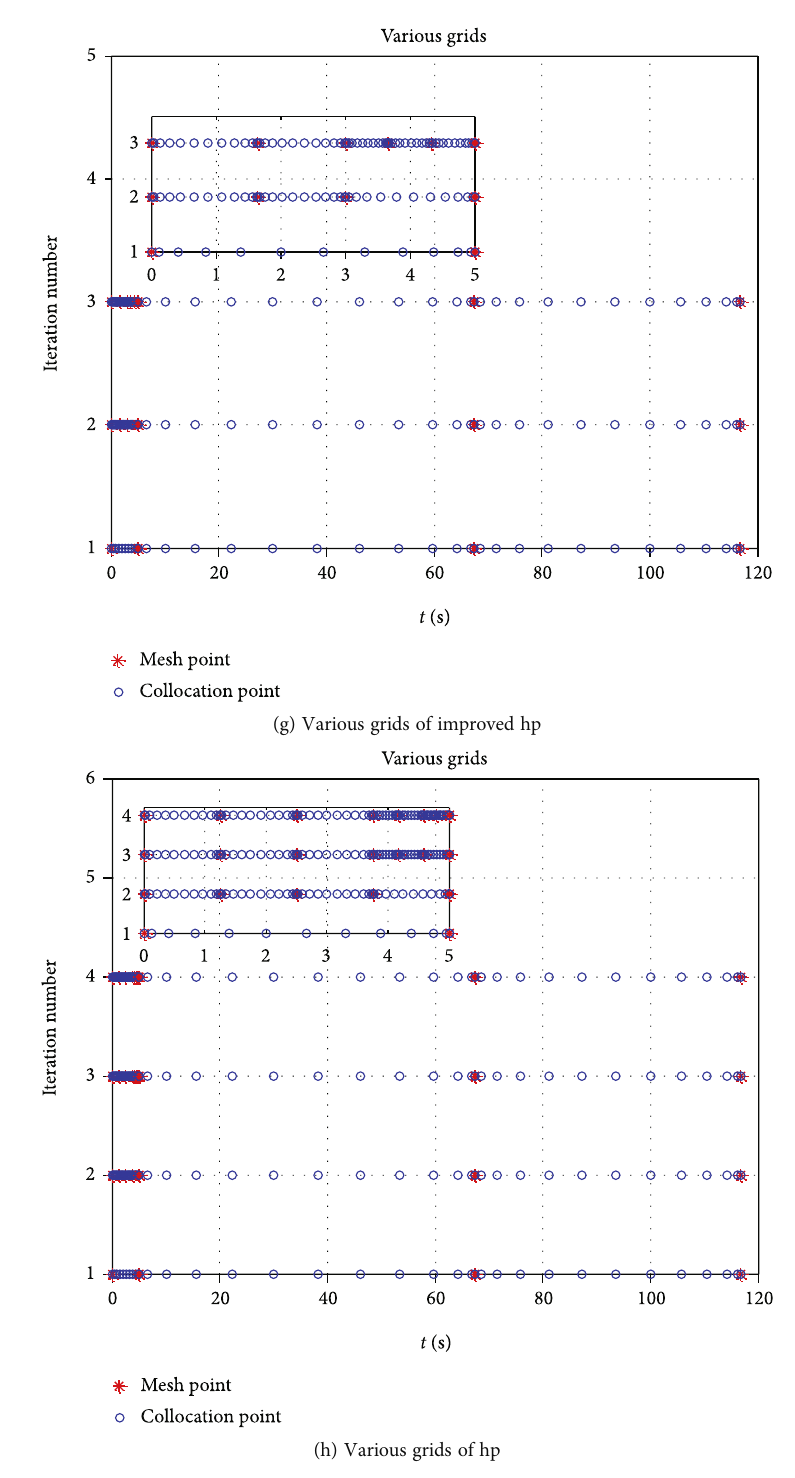
Figure 5: Programmed guidance stage trajectory optimization